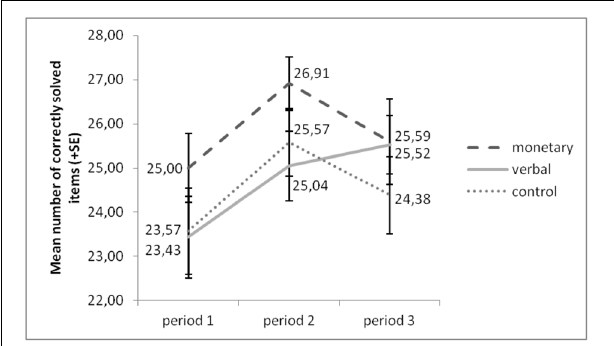
FIGURE 2 | Performance increased from period 1 to period 2 in all groups, but from period 1 to 3 in the verbal reward group